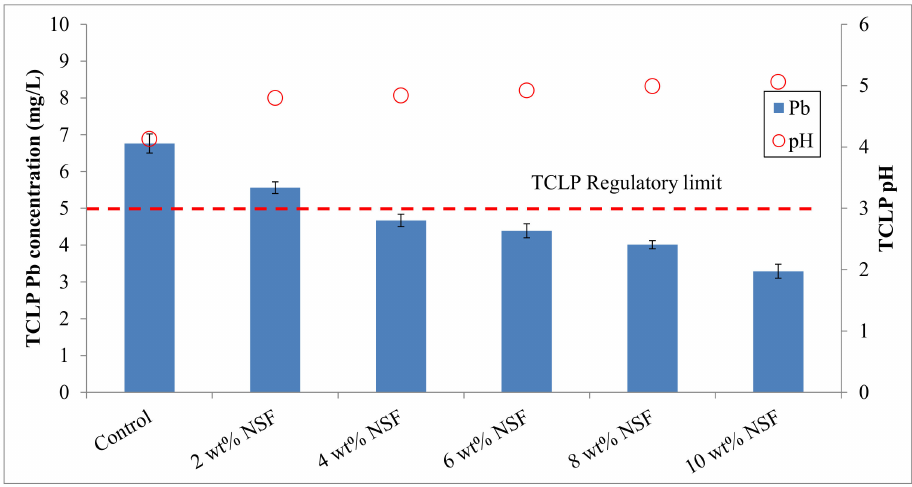
Figure 3. TCLP Pb concentrations for the control sample and natural starfish (NSF)-treated samples.